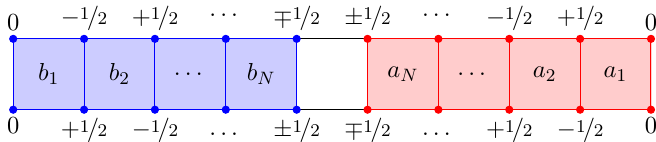
Figure 4. Geometries and SS choices considered for the resource scaling summarized in table 1. The total number of plaquettes is N plaq = 2 N + 1 , with N in subregions A and B